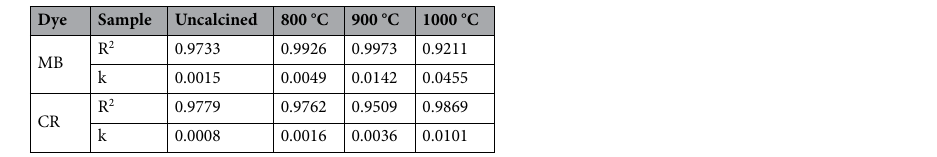
Table 1. Best fit photodegradation kinetic parameters for MB and CR with the four clam shells